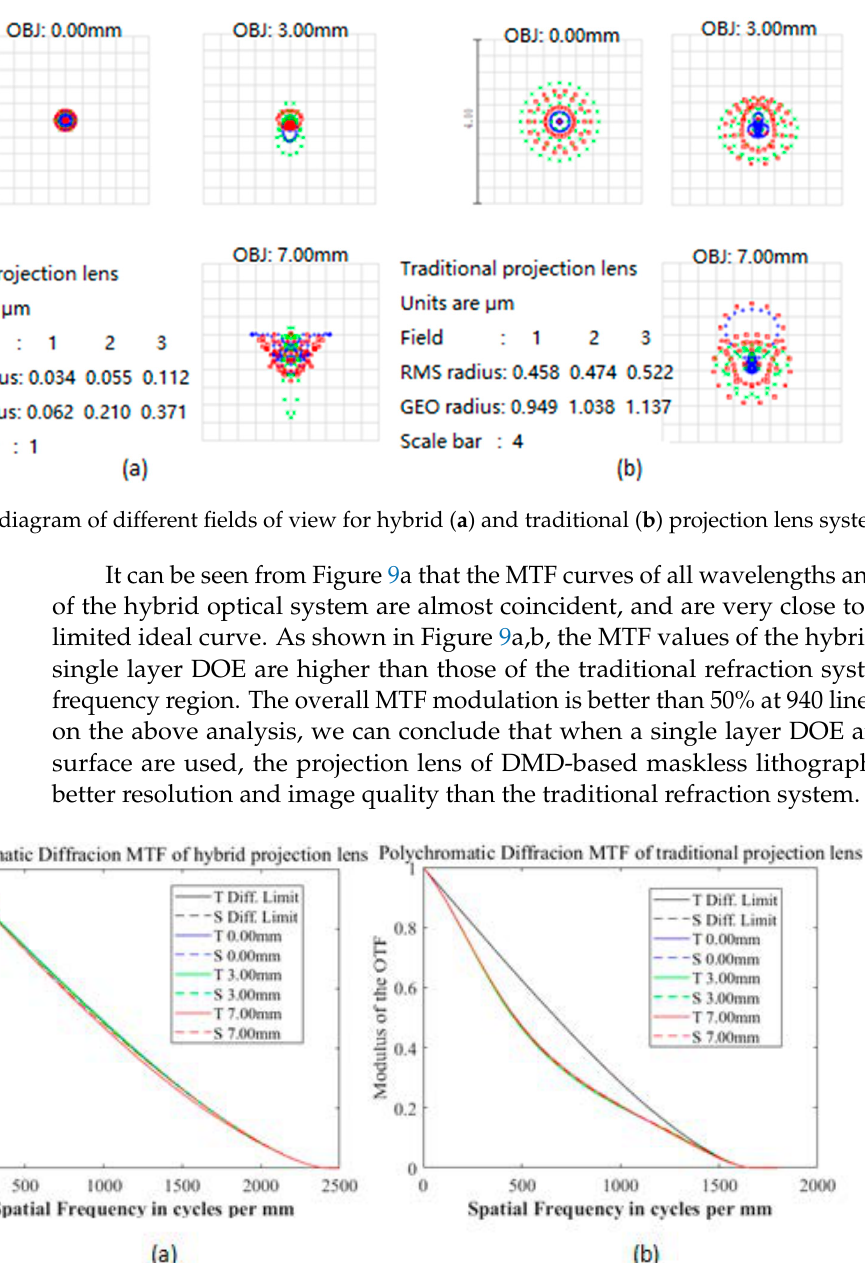
8 Figure 7. Wave aberrations of different fields of view for hybrid ( a ) and traditional ( b ) projection lens systems. It can be seen from Figure 9a that the MTF curves of all wavelengths and fields of view of the hybrid optical system are almost coincident, and are very close to the dif-